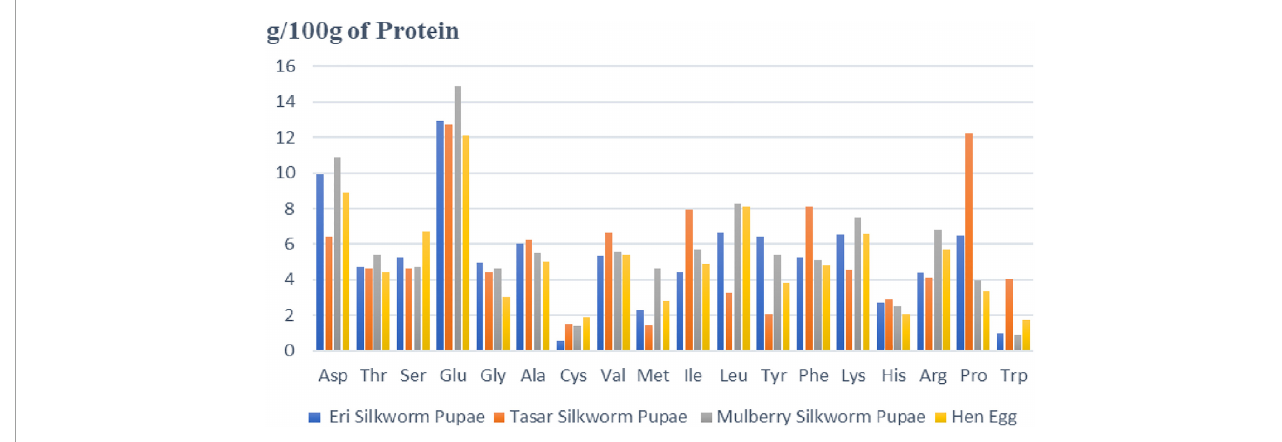
FIGURE3 Representing amount of different amino acids (g amino acid/100 gm of protein) present in different silkworm pupae as compared with hen egg. The figure depicts that amount of essential and non-essential amino acids present in silkworm pupae are higher than the egg of hen. The amount of amino acids present in mulberry pupae is far more than the other silkworm pupae as well as egg of hen. The amino acid composition of the proteins is essentially the same in the different species of silkworm pupae, all consisting of 18 amino acids (except for Eri silkworm pupae). Compared to hen eggs, pupae are higher in Phe and Pro.